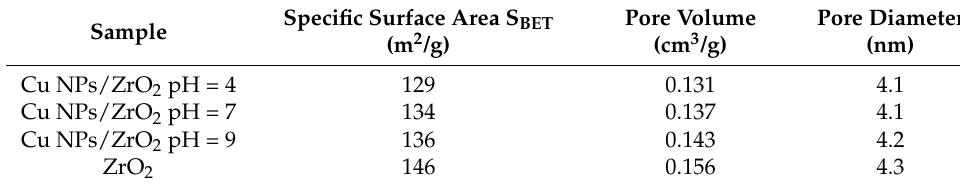
Table 1. Specific surface area and pore volume calculated from N 2